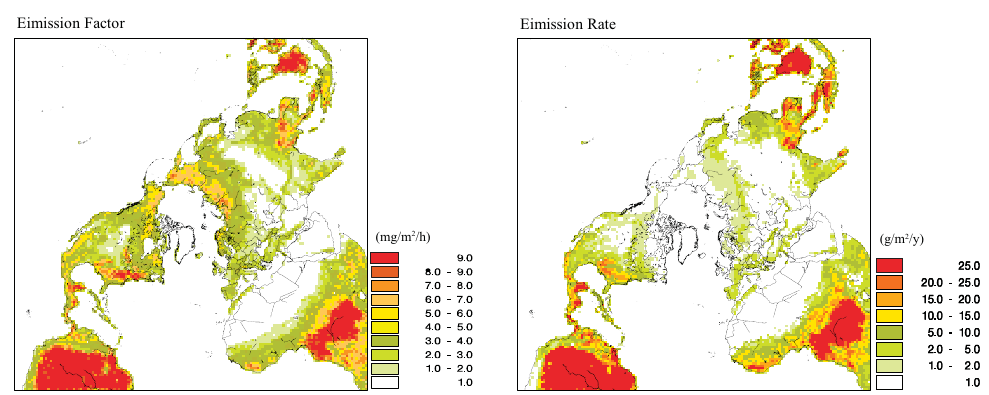
Fig. 4. Distributions of emission rate and its corresponding emission factor as a standard alternative method in MEGAN simulation. The total emission of each location is calculated from sum of a single isoprene EF for each